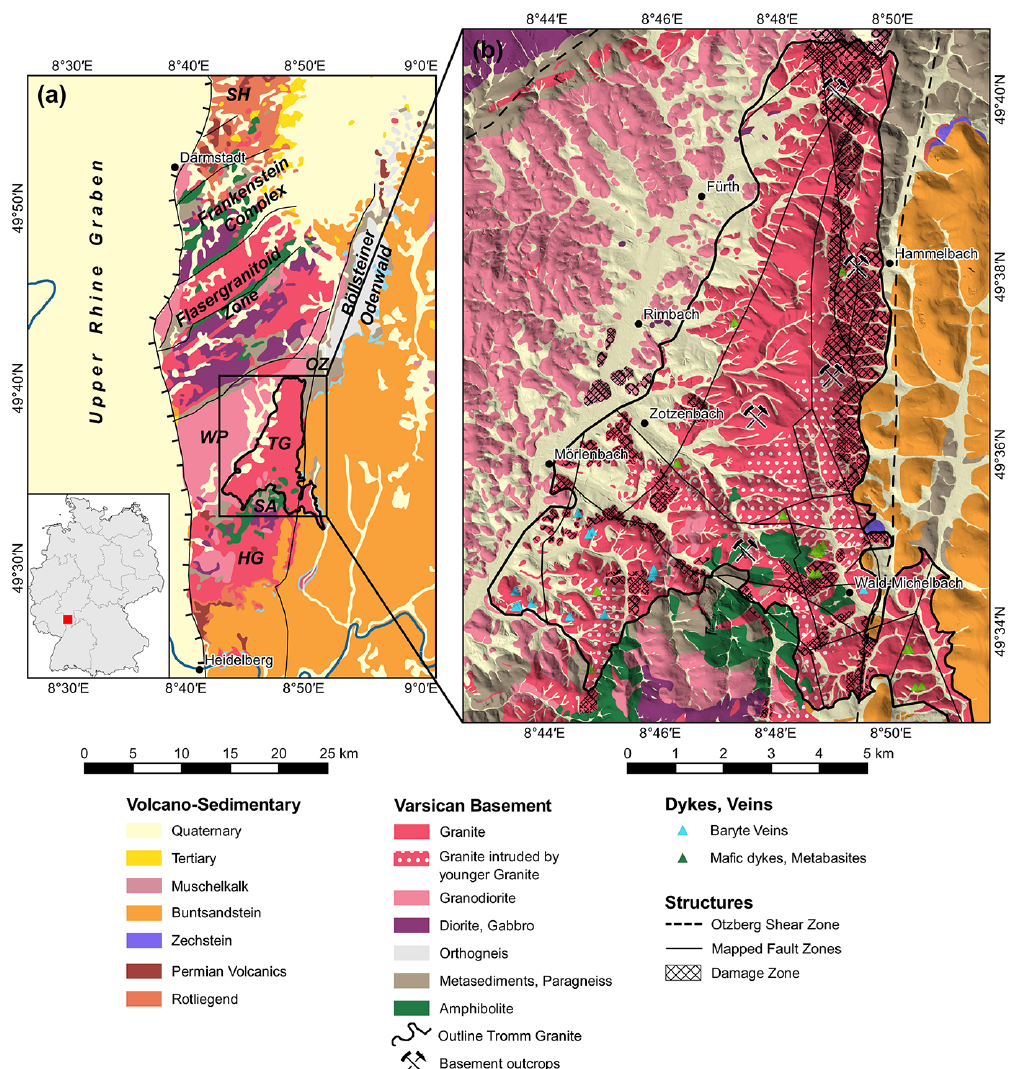
Figure 1. Overview of the study area: (a) geological map of the Odenwald (modified after HLUG, 2007); (b) geological map of the Tromm Granite in the southern Odenwald (Klemm, 1900, 1928, 1929, 1933). The fault zone map was compiled from various geological maps. HG = Heidelberg Granite, OZ = Otzberg Shear Zone, SA = Schollenagglomerat, SH = Sprendlinger Horst, TG = Tromm Granite, WP = Weschnitz